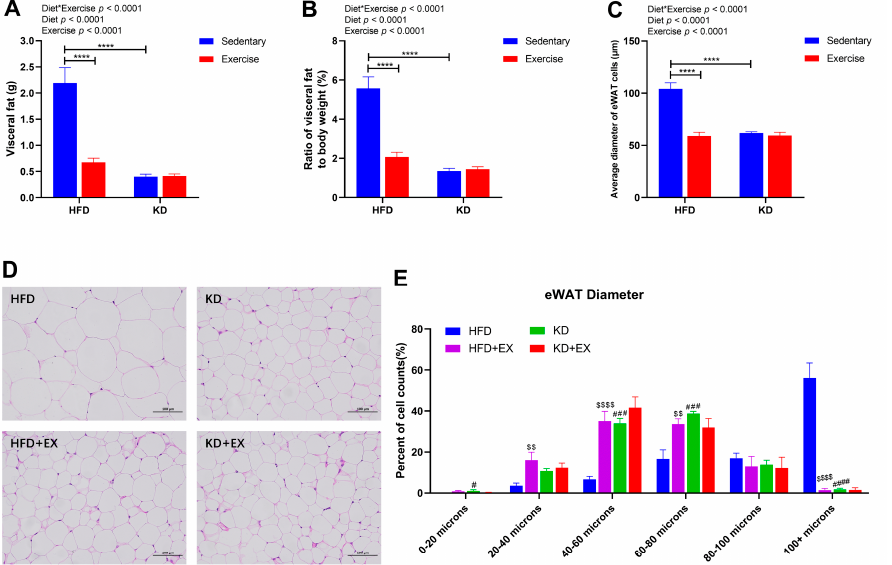
Figure 3. Visceral fat masses and eWAT Diameters in four treatment groups of mice. ( A ) Visceral fat masses (n = 8). ( B ) Ratio of visceral fat to body weight (%) (n = 8). ( C ) Average diameter of eWAT cells (n = 5). ( D ) Representative HE staining of eWAT sections (Scale bars = 100 µ m; Original magnification, 200 × ) (n = 5). ( E ) eWAT diameter range (n = 5). Data are presented as mean ± SEM. For panels ( A – C ), p values from the two-way ANOVA (i.e., main diet and exercise effects and diet*exercise interactions) are presented in the top left corner; Bonferroni post hoc test indicated significant differences (identified with an asterisk) at the following p values, **** p < 0.0001. For panel E, # indicates the KD group is statistically different from the HFD group at the following p values, # p < 0.05, ### p < 0.001, #### p < 0.0001; $ indicates the HFD + EX group is statistically different from the HFD group at the following p values, $$ p < 0.01, $$$$ p <